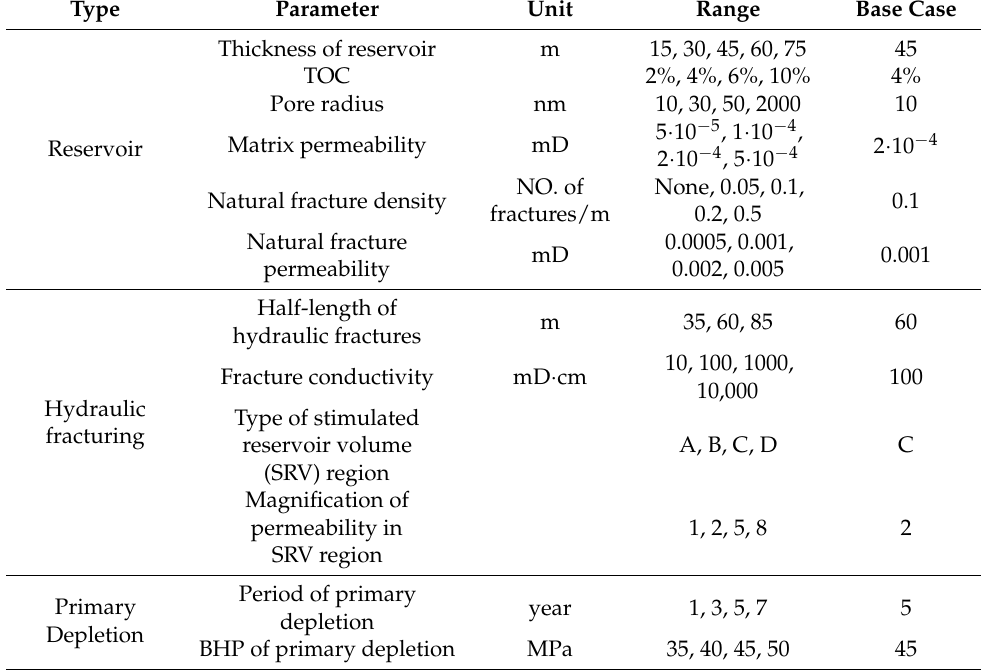
Table 6. Summary of geological and engineering parameters for the